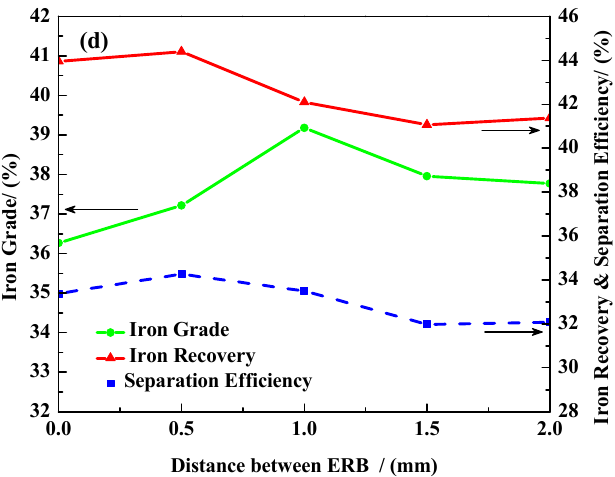
Figure 3. Influence of distance between equidistant ring-shaped bulges (ERB) ( p value) on the separation performance. The matrix diameter is 3 mm, background magnetic induction is 0.8 T, the fluid velocity is 0.05 m/s, the length of stroke is 11.4 mm, and the frequency of pulsation is 30 Hz. ( a ) Column gap d = 2 mm; ( b ) Column gap d = 3 mm; ( c ) Column gap d = 4 mm; ( d ) Column gap d = 5 mm.